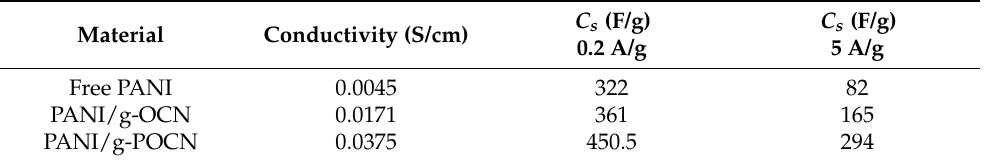
Table 1. Values of C s , Energy density, Power density, and electrical conductivity of Free PANI, PANI/g-OCN, and